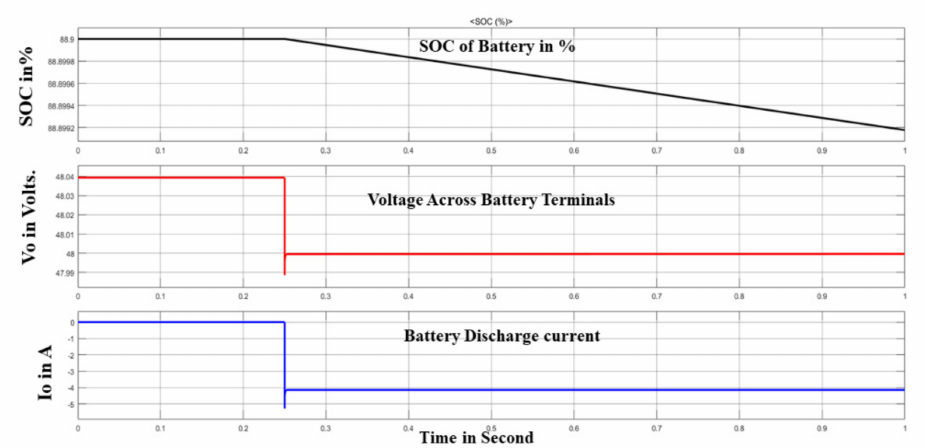
Figure 8. SOC and various load conditions for the auxiliary battery.